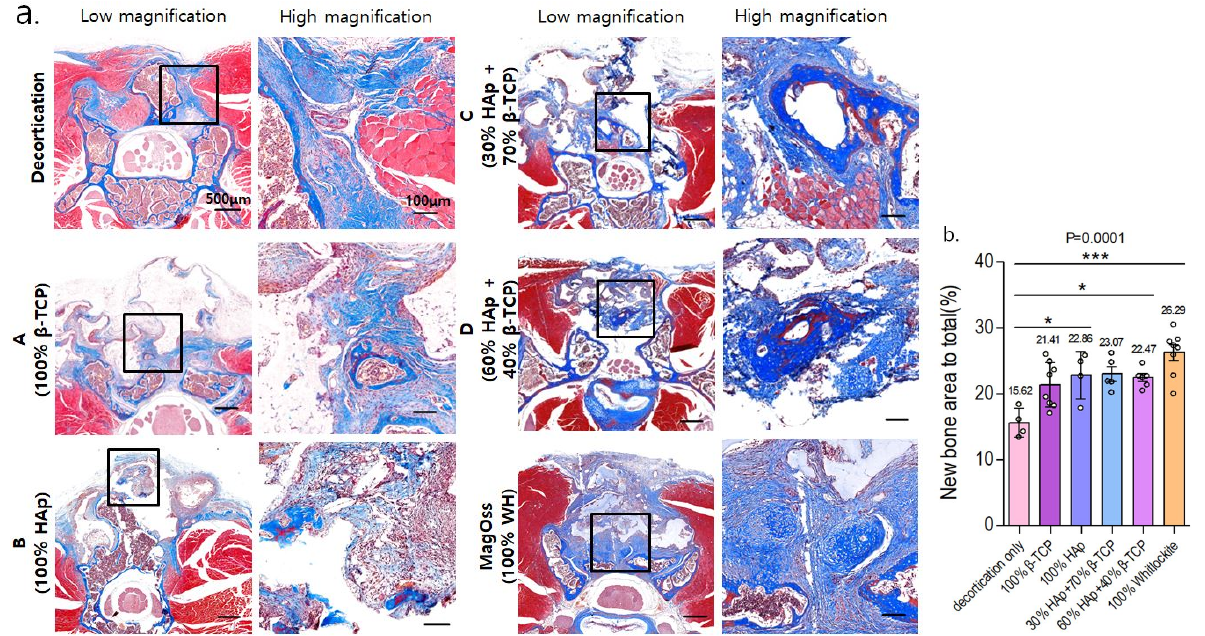
Figure 9. Histological analysis of bone regeneration in a spinal fusion model using Masson trichrome staining. ( a ) Images of cross-sections from each group (scale bar = 500 µ m, 100 µ m). ( b ) Quantitative measurements of new bone area to total bone area (* p < 0.05, *** p < 0.0001). Data were expressed as the mean ± SE (decortication, A, B, MagOss: n = 8/C, D: n =